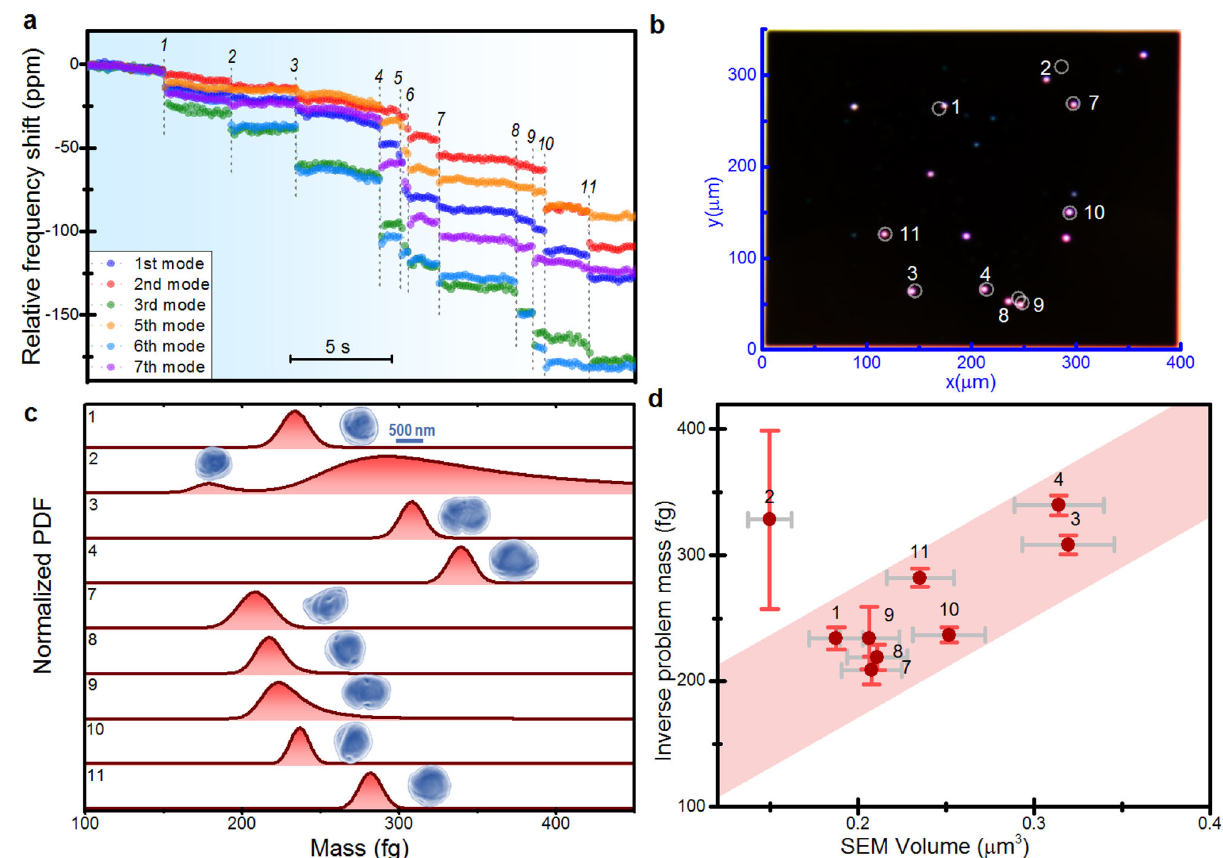
Fig. 3 Validation of the inverse problem method. a Real-time record of the fractional frequency shifts of the selected six vibration modes of an ultrathin membrane during exposure to a fl ux of charged S. epidermidis cells. Soft-landing of individual cells on the membrane gives rise to quasi-instantaneous and simultaneous shifts of the tracked eigenfrequencies. The observed 11 tentative adsorption events are numbered. b Dark- fi eld optical image of the membrane after the experiment shown in a . The positions of the bacteria estimated by the inverse problem method are shown as circles. Most of the predicted positions match dark- fi eld spots that correspond with bacteria cells. Events 5 and 6 could not be resolved by the inverse method due to their short temporal separation. c Probability distribution function (PDF) of the individual bacteria mass obtained by the inverse problem method. The PDFs are normalized to the maximum. The insets show a detailed SEM image of the identi fi ed bacteria cells at each numbered position. d Mean mass of the bacteria derived by the inverse problem method vs the volume estimated from the SEM images of the bacteria. The mass error corresponds to the standard deviation of the dry mass PDFs. The volume is estimated by assuming an ellipsoid for the bacteria shape. We use the mean value of the in-plane diameters for the out-of-plane diameter. The volume error is obtained from the uncertainty in the three diameters of the